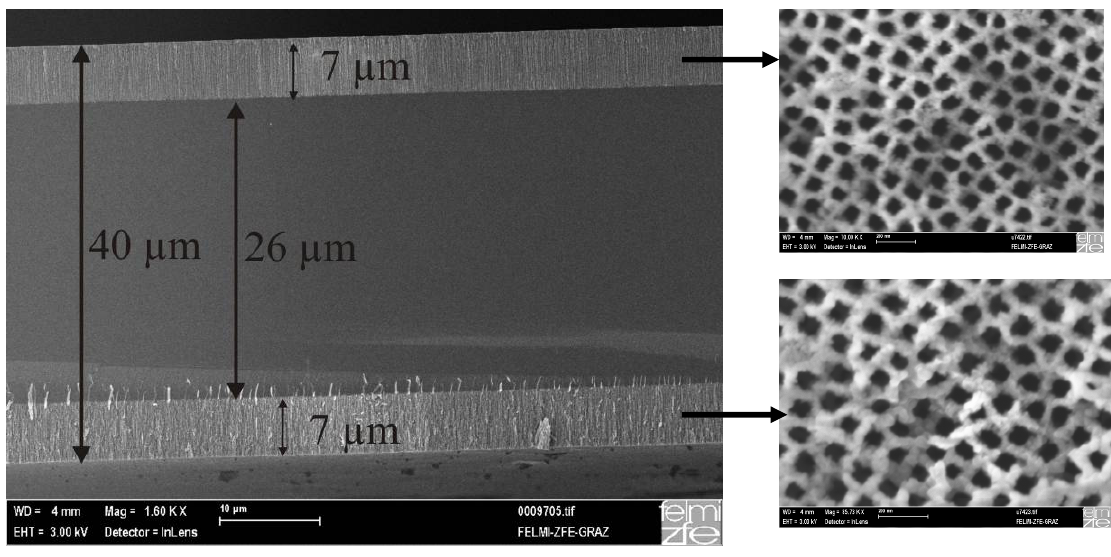
Figure 15. Ultrathin wafer with an entire thickness of 40 µm etched on both sides. The two layers exhibit a thickness of about 7 µm each. On the right side the corresponding top view images show that the morphology is alike for both